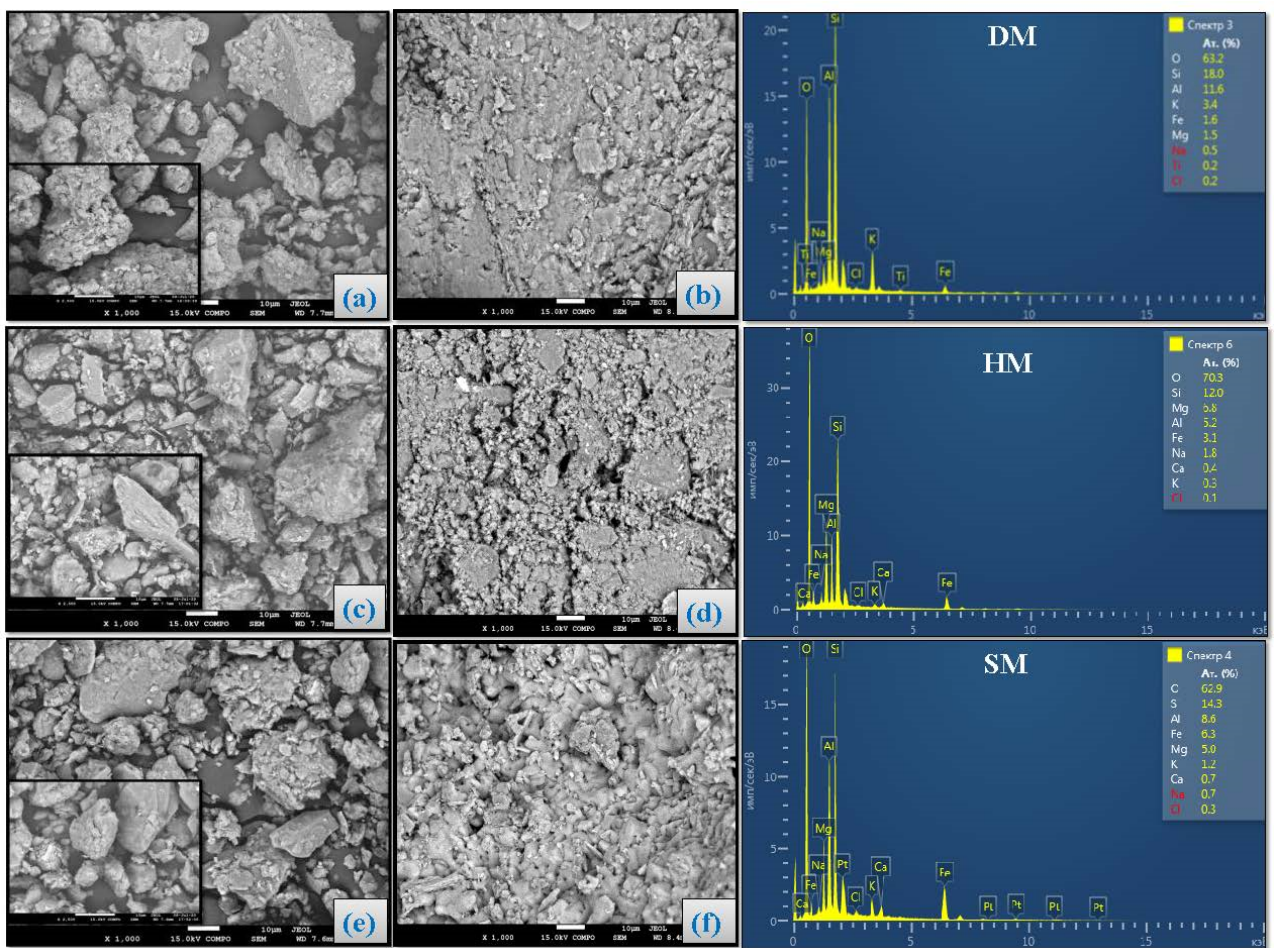
Figure 12. SEM images of ( a ) DM powder and ( b ) unfired DM brick, ( c ) HM powder and ( d ) unfired HM brick, ( e ) SM powder and ( f ) unfired SM brick. EDX spectrum of DM, HM, and SM are shown on the right.